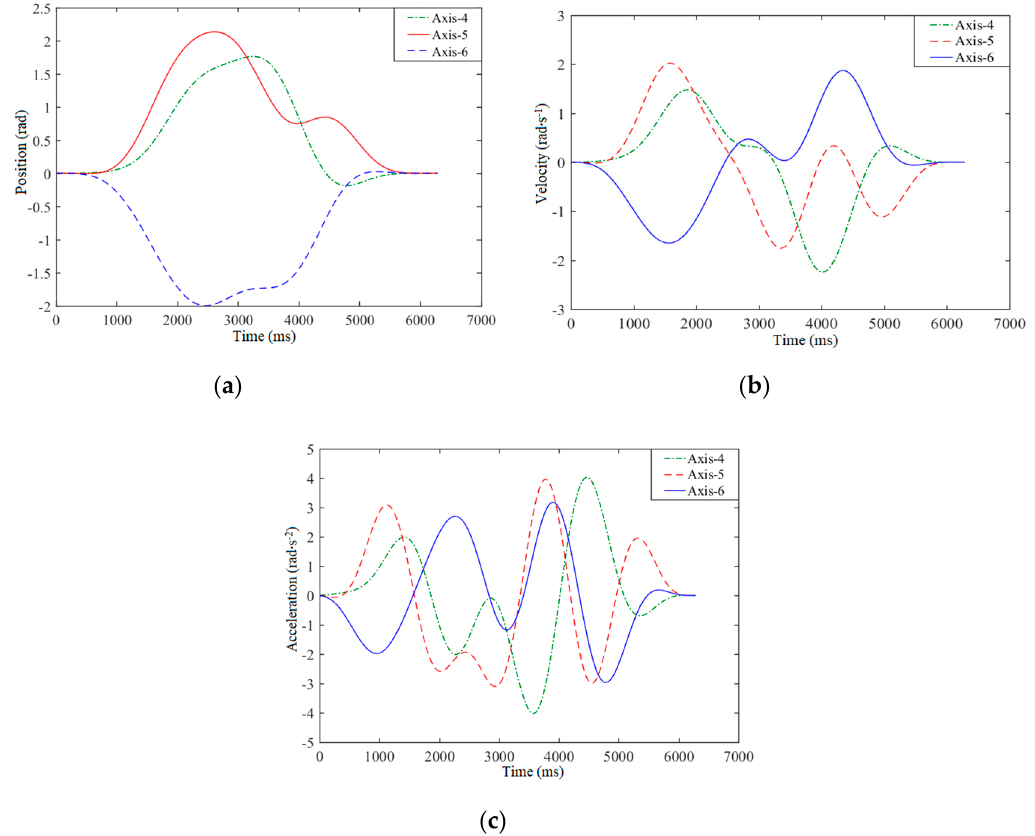
Figure 3. Excitation trajectory for parameter identification. ( a )–( c ) are the position, velocity, and acceleration of excitation trajectory for parameter identification, respectively .